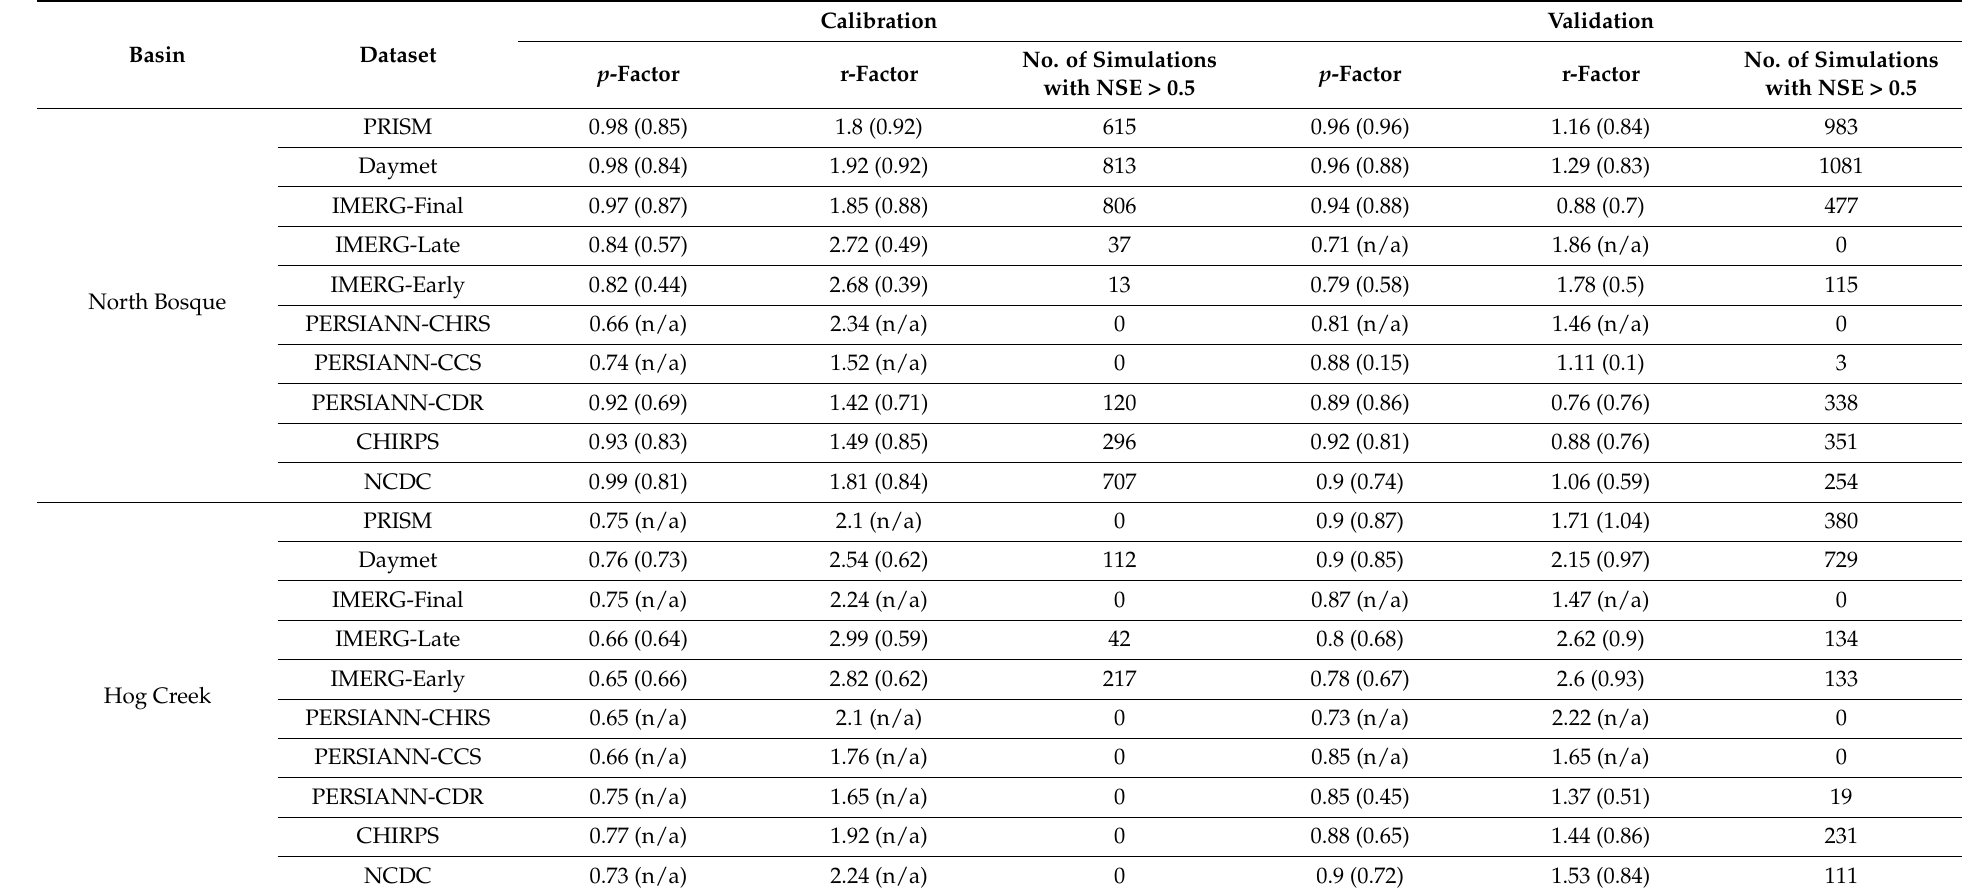
Table 3. p -factor, r-factor, and the number of parameter sets with NSE > 0.5 for different precipitation data sets. The values in the parenthesis are NSE